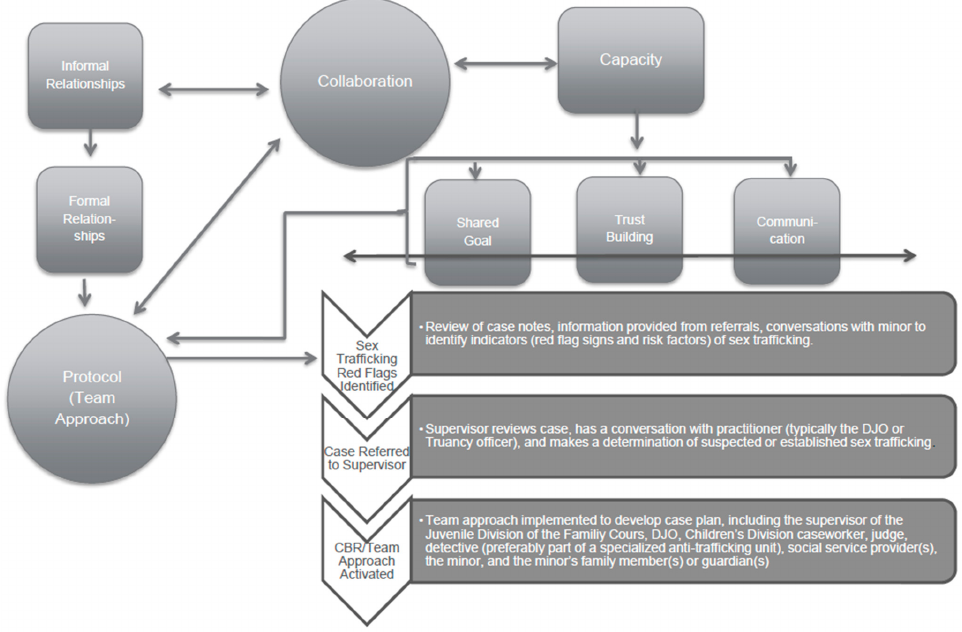
Figure 3. Conceptual Model of Mezzo Level Collaborative Anti-Trafficking